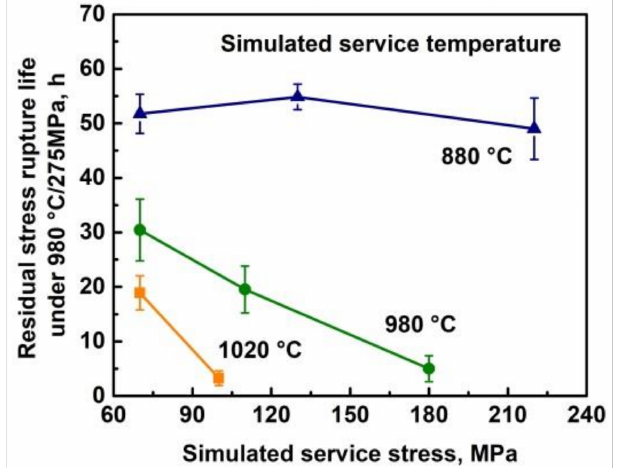
Figure 1. Residual stress rupture life under 980 ◦ C/275 MPa under the different simulated service en- vironmental conditions, the blue, green and yellow lines correspond to simulated service temperature of 880 ◦ C, 980 ◦ C and 1020 ◦ C,